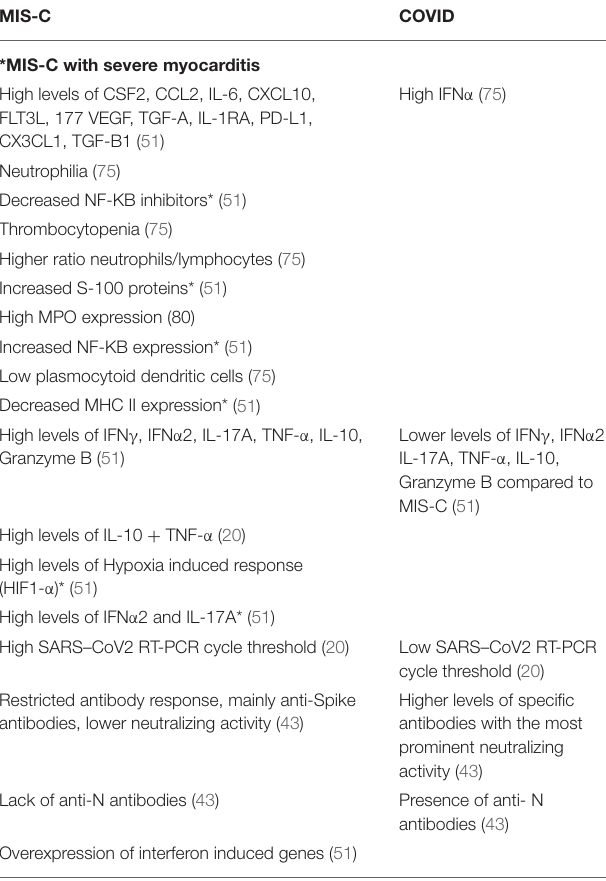
TABLE 2 | Merging knowledge from different studies. MIS-C